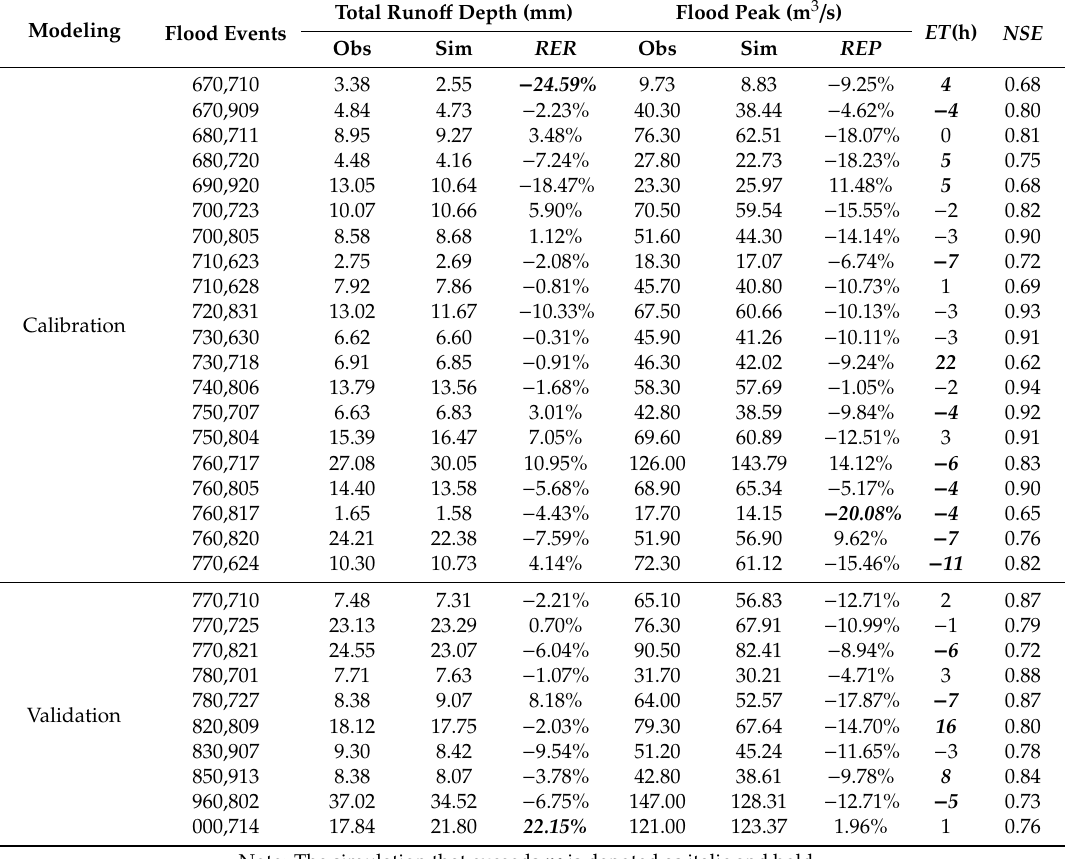
Table 2. Observation, simulation and performance evaluation measures by SVHM model in Xiuwu Basin. Modeling